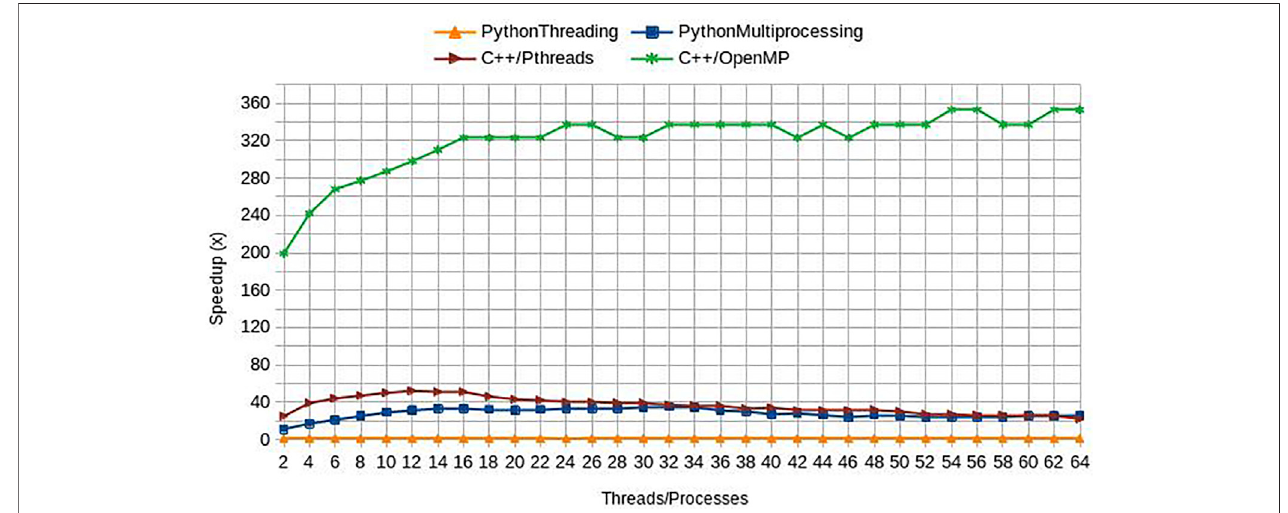
FIGURE 4 | Performance of new Geom fi nder implementations. The original (PythonThreading) and three new versions, including parallel programming paradigm and code optimization, were compared against a sequential Python version (Sequential) developed with benchmarking purposes. These versions were built using Python 2.7 with multiprocessing (PythonMultiprocessing), C++ with POSIX threads (C++/Pthreads), and C++ with OpenMP annotations (C++/OpenMP). As is denoted bythegreenlinein thegraph,theversion C++/OpenMPalways showedbetter performance than theotherimplementations, reachingtheirbest acceleration using 54 threads: 353x speedup compared to Sequential version. Thus, the version C++/OpenMP was selected for the implementation of the new server of Geom fi nder. The experimental setup used in the comparisons is a 32 Intel Xeon CPU E5-2683 (2.10 GHz) SMP system with hyperthreading enabled (64 virtual cores/threads), 252 GB RAM, 40 MB Intel Smart Cache.